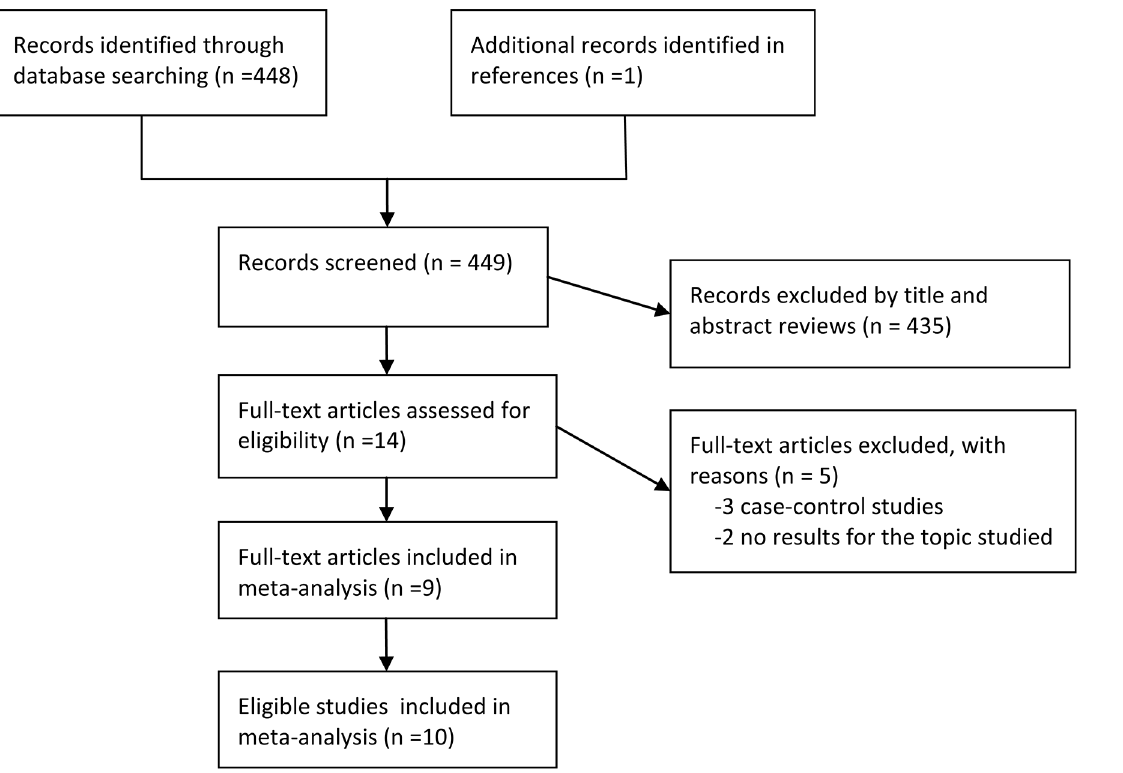
Fig 1. Flow diagram of literature search for the